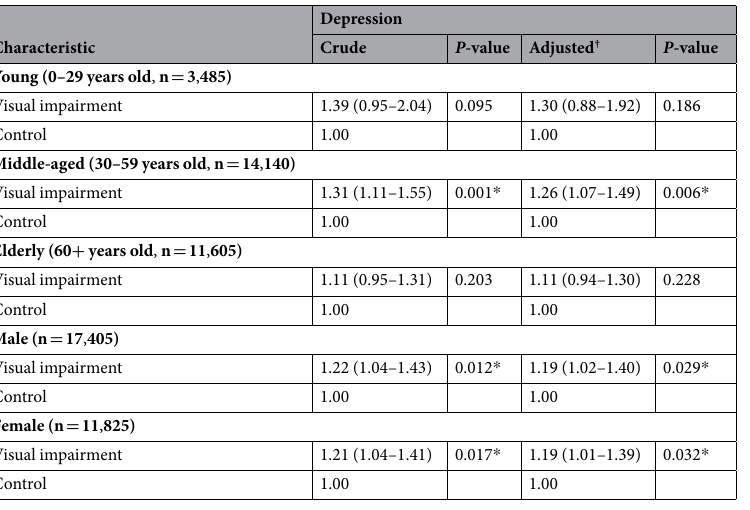
Table 3. Crude and adjusted hazard ratios (95% confidence interval) of visual impairment for depression for age and sex subgroups. * Cox proportional hazard regression model; significant at P < 0.05. Adjusted model for age, sex, income, region of residence, hypertension, diabetes, and